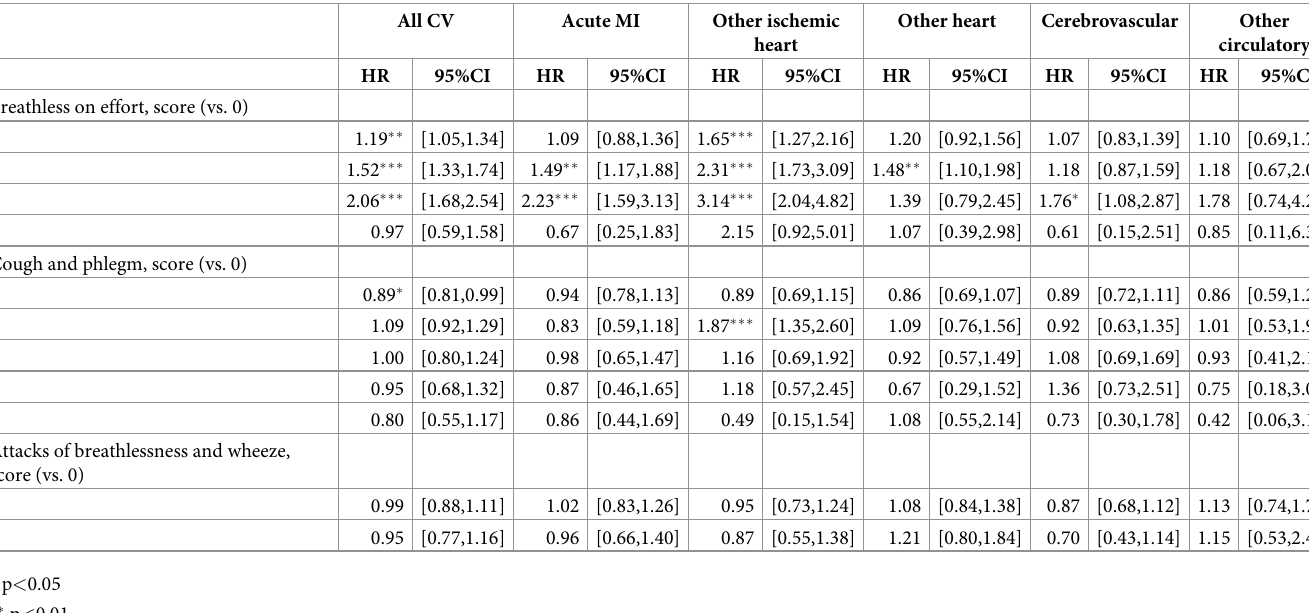
Table 6. Never-smokers. Hazard ratios with 95% confidence intervals and p-values according to cause of death, multivariable proportional hazards regression analysis adjusted for sex, education, occupational exposure to gas/dust, previous angina pectoris, previous other heart disease and previous myocardial infarction, and birth cohort (n =